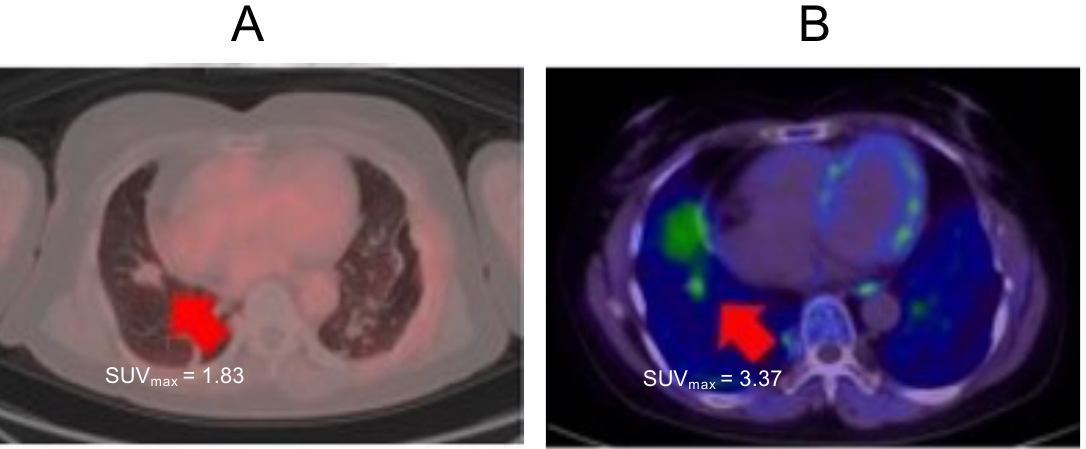
Figure 5. Lung nodule. ( A ): FDG ‐ PET imaging. ( B ): MET ‐ PET imaging. Arrows indicate lung metastasis from renal cell carcinoma.